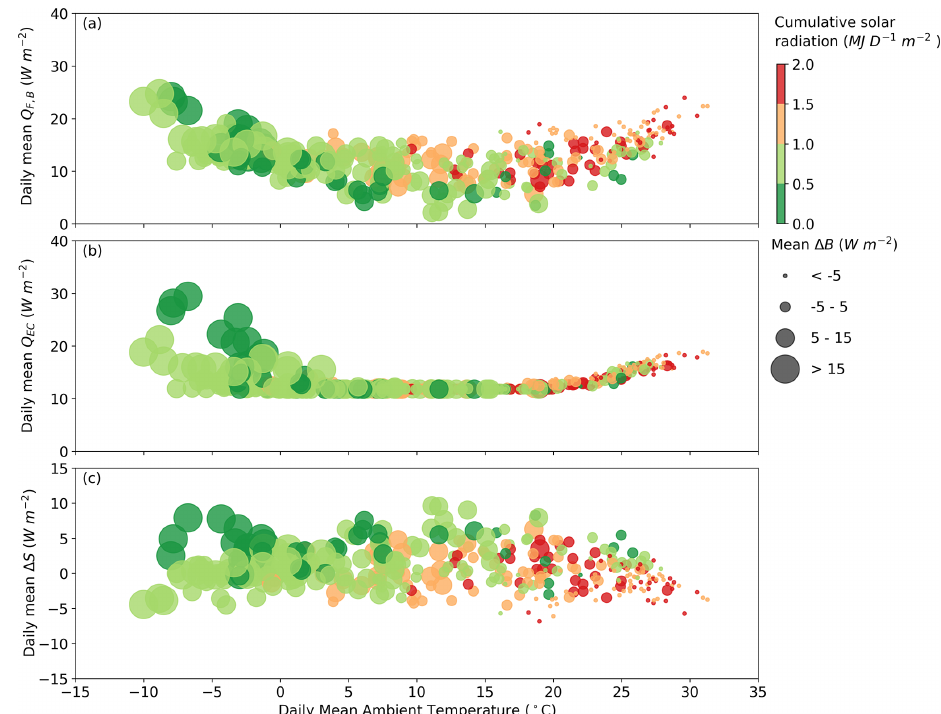
Figure 5. Daily results for the ov 3 –us case stratified by daily cumulative solar radiation (colour) and daily mean available energy to the building (size) Eq. (9) associated with human activities, with mean external air (ambient) temperature and (a) mean anthropogenic heat flux, (b) energy consumption and (c) difference in storage heat